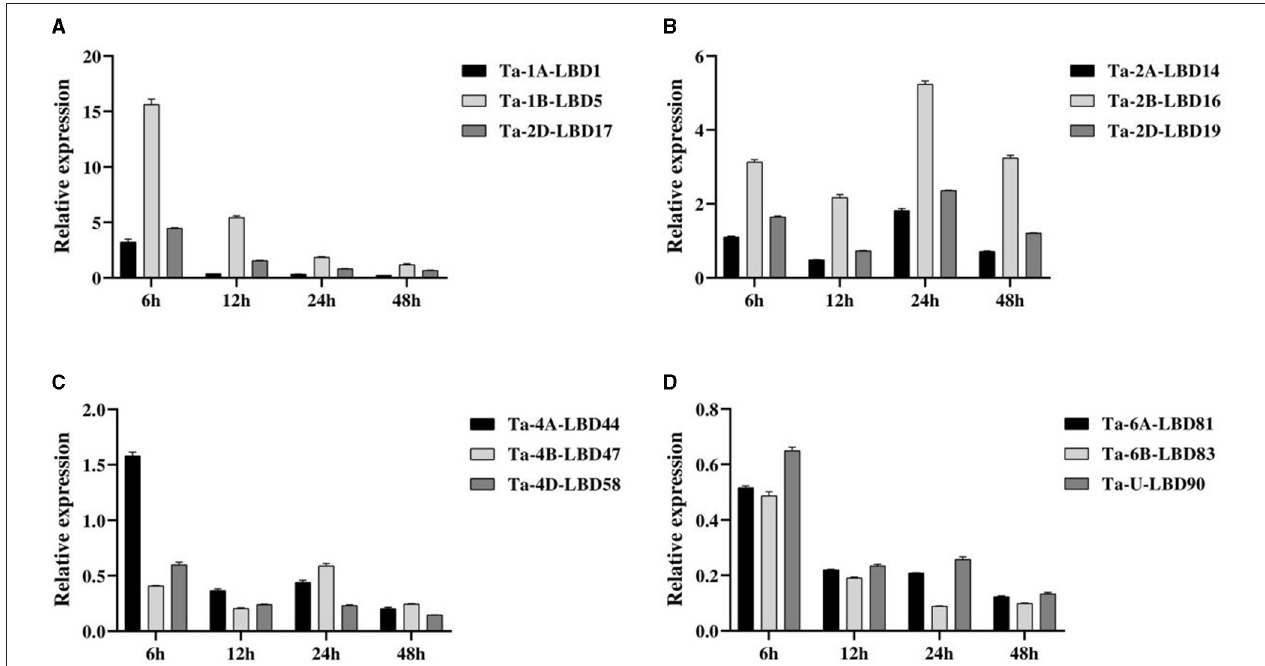
FIGURE 8 | The expressions of the 12 TaLBDs belonging to four homologous groups under salt stress were investigated using QPCR method. The relative expression levels were calculated and compared. Error bars represent standard errors of three independent replicates. TaLBDs, wheat lateral organ boundaries domain genes.